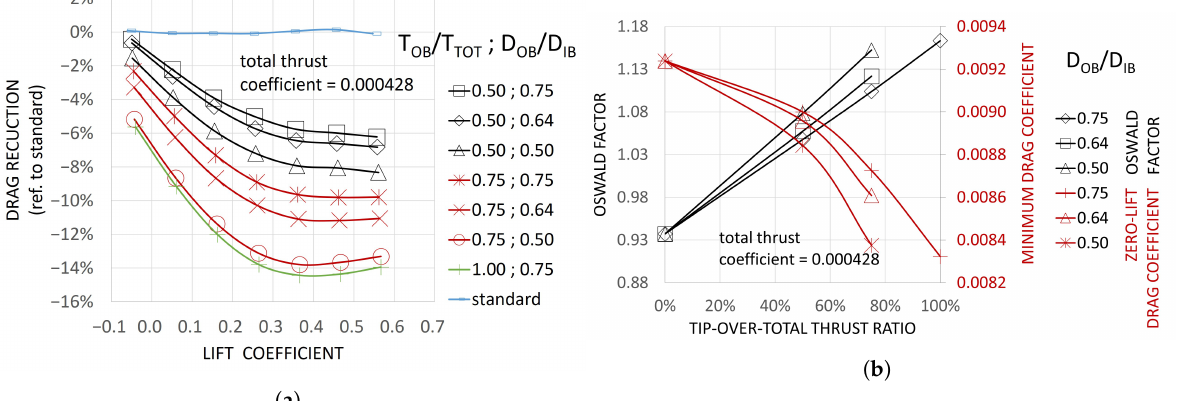
Figure 11. IB and OB propellers effect in cruise conditions ( M = 0.480; Re = 16.6 × 10 6 ): ( a ) Relative drag reduction regarding standard case (STD, Table 2); ( b ) Oswald factor and zero-lift drag